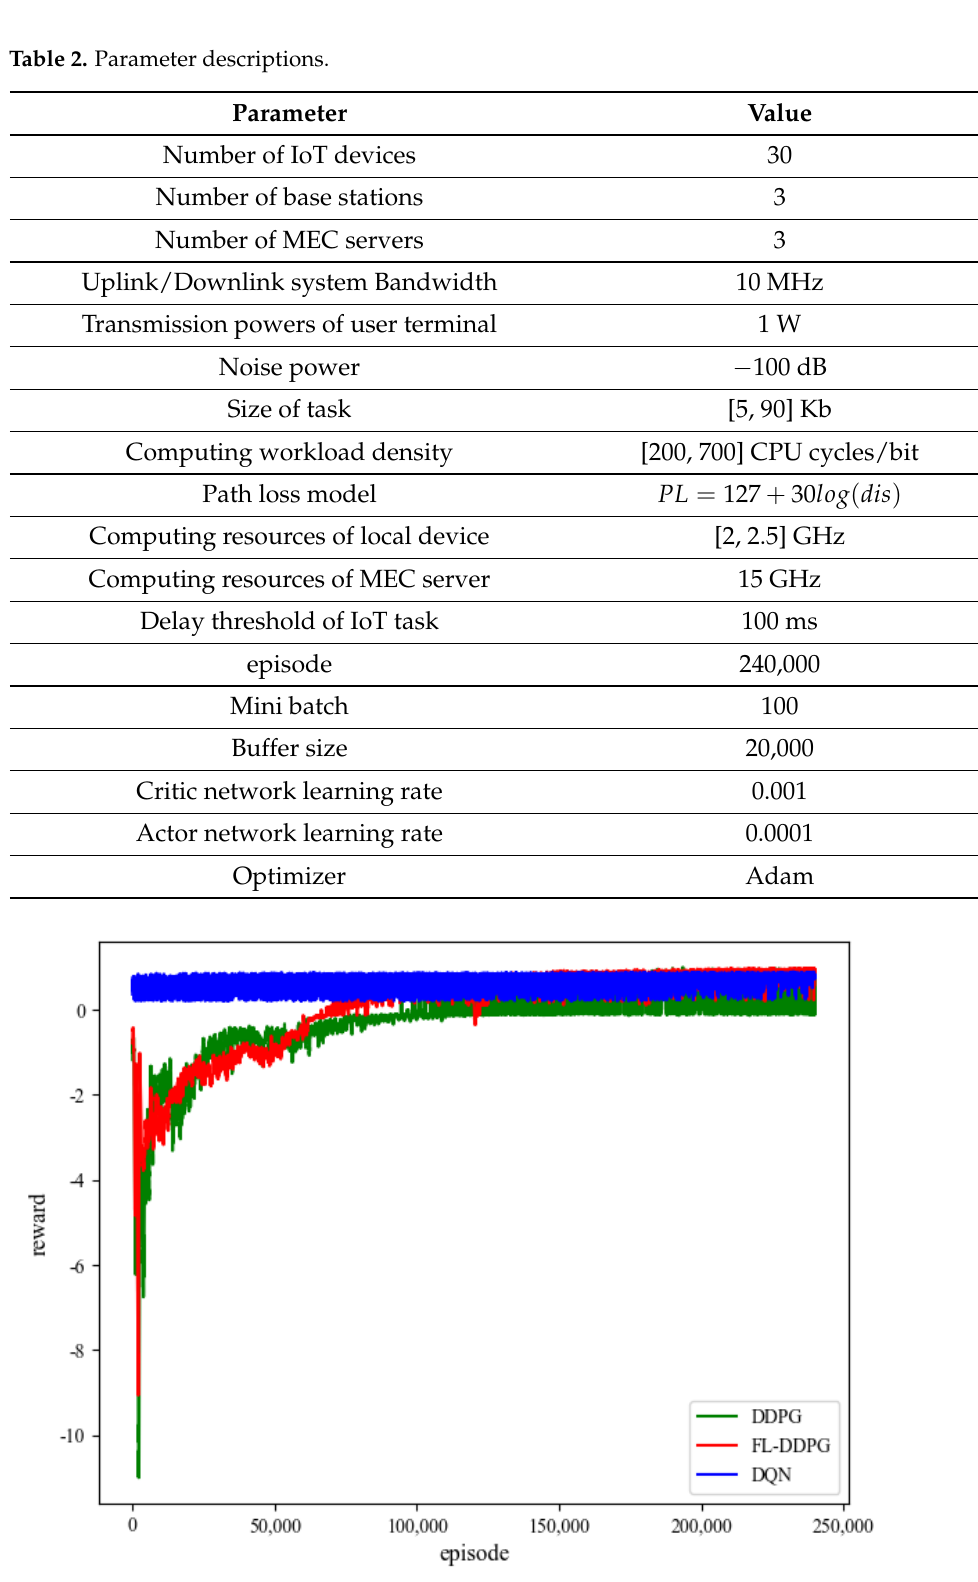
Figure 3. Convergence property of different